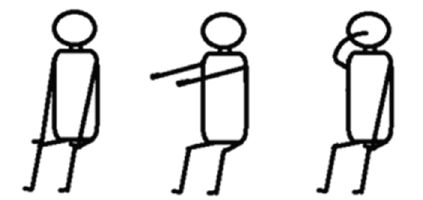
Figure 1. Test tasks for parkinsonian tremor assessment: ( left action ) rest tremor, ( middle action ) postural tremor, and ( right action ) action